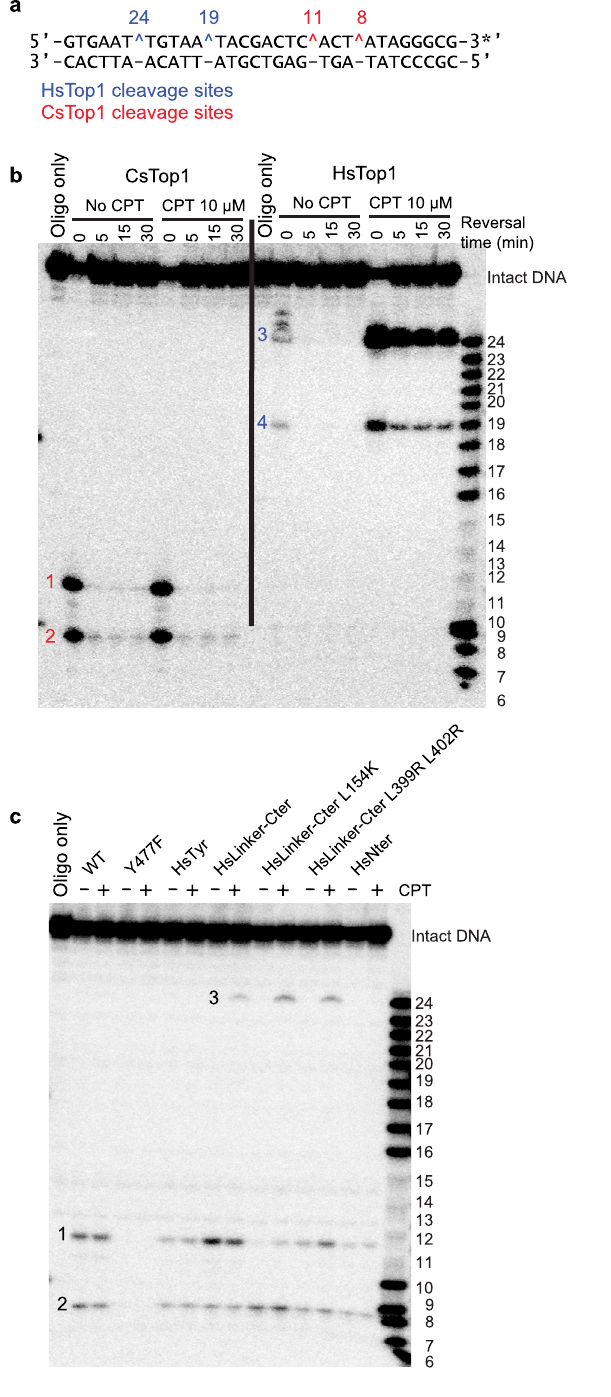
Fig. 6 TOP1-mediated DNA cleavage assays. a Sequence of the oligonucleotide used in the assays. The HsTOP1 cleavage site (CPT-dependent) and CsTOP1 cleavage site (CPT-independent) are shown in blue and red, respectively. The star represents the position of 32 P labelling. Ladder numbering represents the size of the DNA in nucleotides. b Cleavage of the oligonucleotide with WT CsTOP1 and HsTOP1 in the presence or absence of CPT. The reversion of TOP1ccs is monitored after the addition of 350 mM NaCl. c Cleavage of the oligonucleotide by WT and the indicated biologically engineered CsTOP1 (chimera) in the presence or absence of CPT. This experiment was done